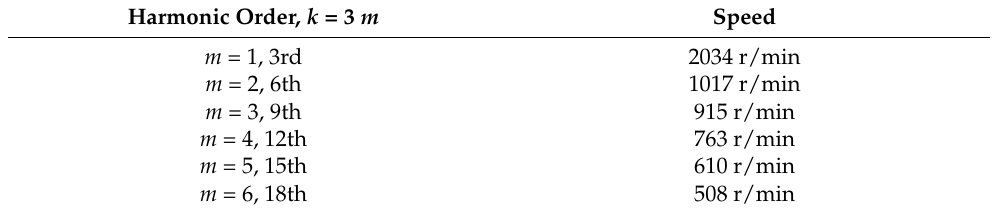
Table 1. Speed of SRM when the frequency of current harmonics coincide with the 2nd order natural. Harmonic Order, k = 3 m Speed m = 1, 3rd 2034 r/min m = 2,